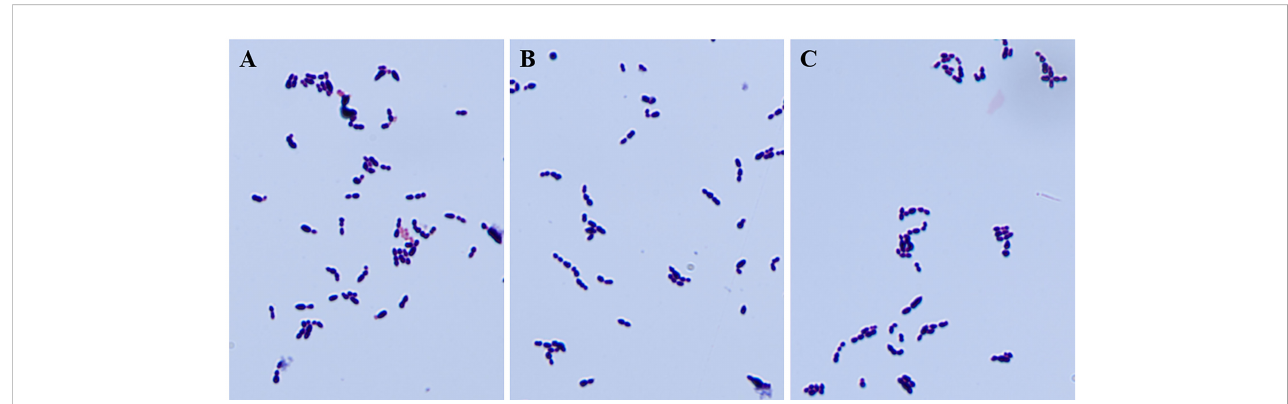
FIGURE 1 Gram staining of strains before and after deletion of cba gene and complementary deletion. The knockout of the cba gene does not affect the gram staining properties and appearance of SS. (A-C) are the results of microscopic examination of the gram staining of SS9-P10, SS9-P10: D cba , and SS9-P10: C D cba , respectively.